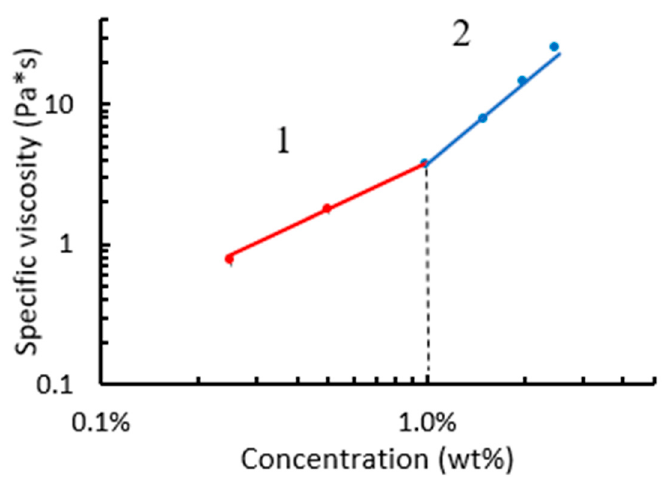
Figure 3. Dependence of the specific viscosity on cellulose acetate solutions concentration in water at 25 ° C, with power-law fits. The dashed line represents the overlap concentrations c*.